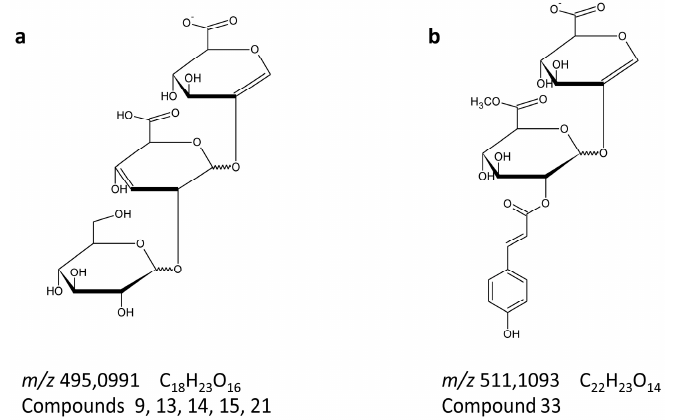
Figure 4. Structures of the characteristic product ions of flavonoid glucuronates, ( a ) m/z 495 found in acylated at middle sugar moiety compounds, with linear fragment comprising two units of glucuronic acid and one unit of glucose; and ( b ) m / z 511 corresponding to methylated diglucuronate acylated with p -coumaric acid. Ions were found in the collision induced dissociation fragmentation (CID MS/MS) spectra, registered in negative mode, referred to the compounds from Table 1 and spectra in supplementary data.